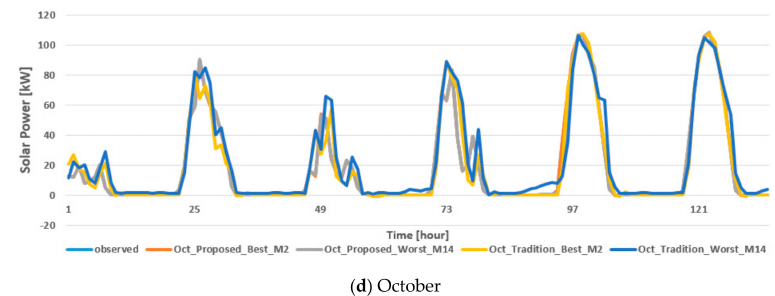
Figure 11. Comparison of the best and worst models for the proposed and traditional LSTM by season.